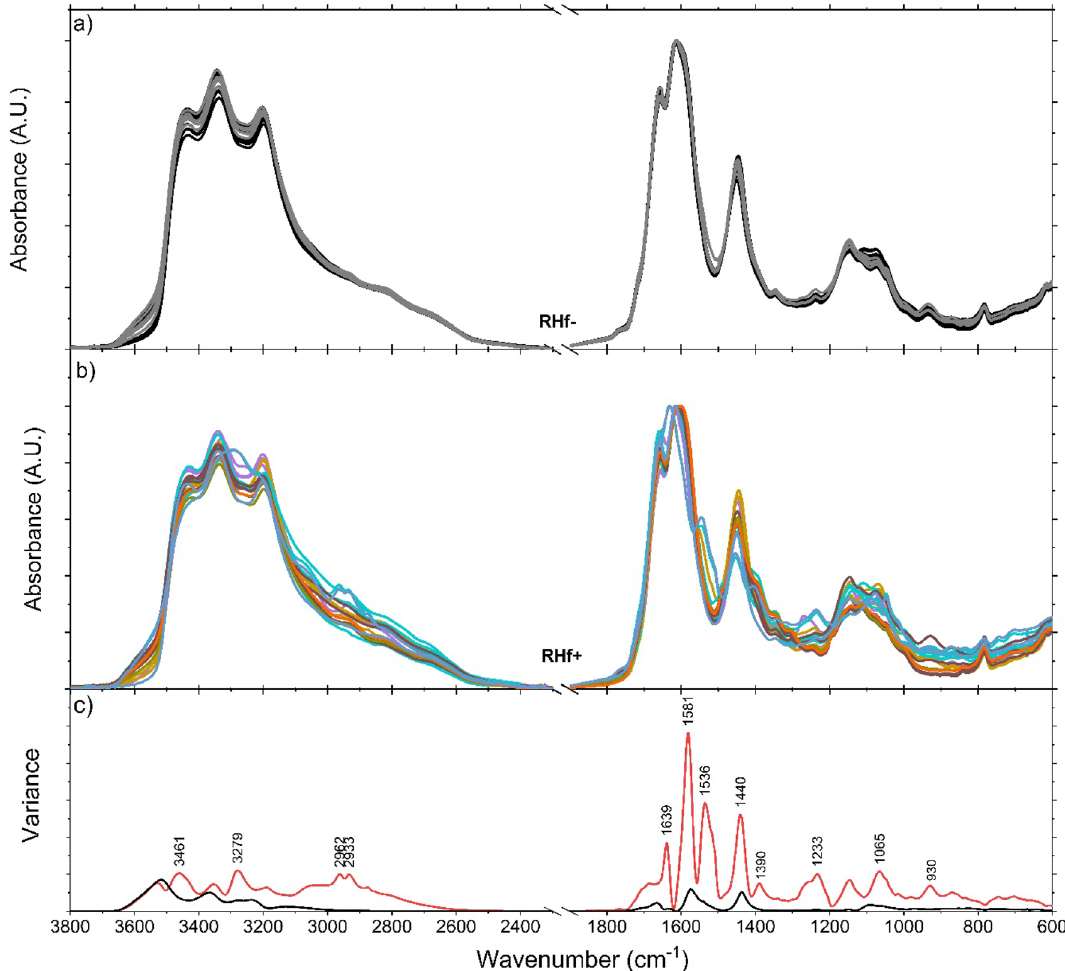
Figure 2. Overlaid urine spectra of RHf (−) (n = 20) and RHf (+) (n = 17) participants. Each spectrum is the average of triplet measurement of the same sample. Spectra are ATR- and baseline-corrected and normalized to the 1610/cm urea peak. Raw spectra are also provided in Fig. S1 (Supporting Information). Lower panel ( c ) shows the calculated variances of the control group (black) and the RHf (+) spectra group samples are tightly clustered whereas the RHf (+) samples exhibit a wider distribution relative to the control samples. PC1, PC2 and PC3 explain 77.7% of total variance. The scores of RHf (−) samples lie on the positive side of the PC2 scores, while those of RHf (+) are mostly on the negative side. It is important to note that PCA classi- fied the control group as close to one-another despite spectral variations due to age, gender, and dietary habits. It is also evident that the in-class variation of the RHf (+) samples is higher than that of the RHf (−) samples. In the clinical understanding of hyperfiltraters, there is heterogeneity among these individuals in terms of the cause and the results. Urine composition shows this heterogeneity as well. Evaluation of Figs. 2c and 3a (second derivative of spectra), Fig. 3b (clustering of normofiltraters is clearly observed on 3D scatter plot of PCA scores), Fig. 3c (clustering is seen especially based on PC2 axis), Fig. 3d (loading plot of PCA) reveals that there are com- mon differences between the spectra of RHf (+) and (−) groups. Table S1 (Supporting Information) lists these peaks and their proposed functional group assignments. The vibrations at ~ 840, 1000, 1200, 1390, 1492, and 1540/cm contributed mostly to the spectral separation of the two groups along the PC2 axis (Fig. 3c). These peaks mostly originate from urea, uric acid, creatinine, citrate, sulphate, and phosphate groups in a healthy popula- tion. On other hand, contribution of proteins at 1545/cm and purines and/or purine derivatives at 1240/cm and 1100–970/cm should also be taken into consideration in our RHf (+) population. The statistical significances of all six peaks are further tested by one-way ANOVA, followed by Fisher’s LDS post hoc test (Fig. 4), and all are found to be statistically significant in discriminating RHf (+) samples. Origin and contribution of the major IR peaks to the observed spectral diversity. When the spectral variances are compared, the degree of changes at any given spectral position is much higher with the RHf (+) group (Fig. 2c). This observation implies that RHf is not characterized by a single biomarker band but, instead, it is an observable spectral deviation from the normal (control group) at multiple points. In order